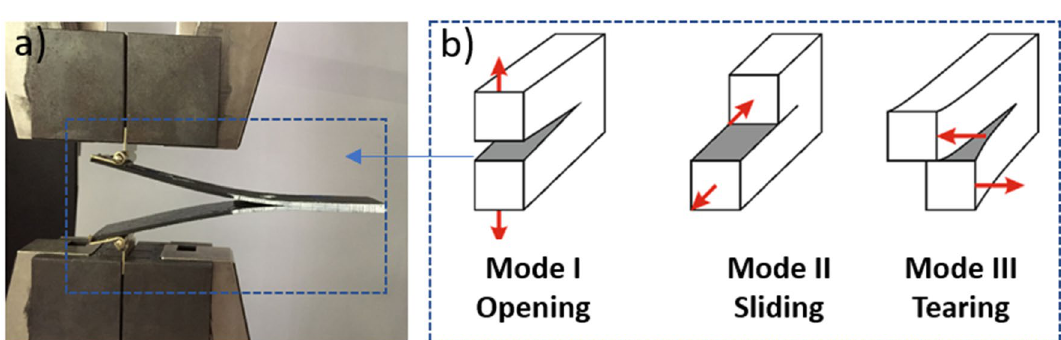
Figure 5. ( a ) Specimen during Mode I test, ( b ) fracture modes and applied loadings.